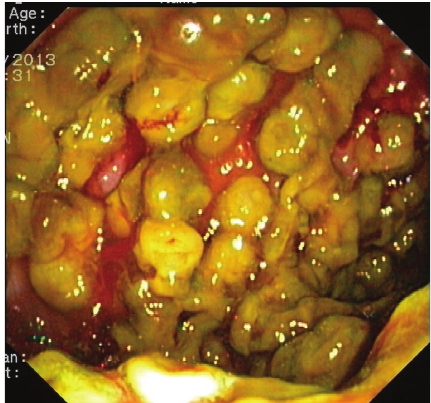
Figure 2: Endoscopic view of the sigmoid colon shows multiple polypoid lesions covered with a thick yellowish cap and active mucosal oozing, sparing small areas of normal mucosa.